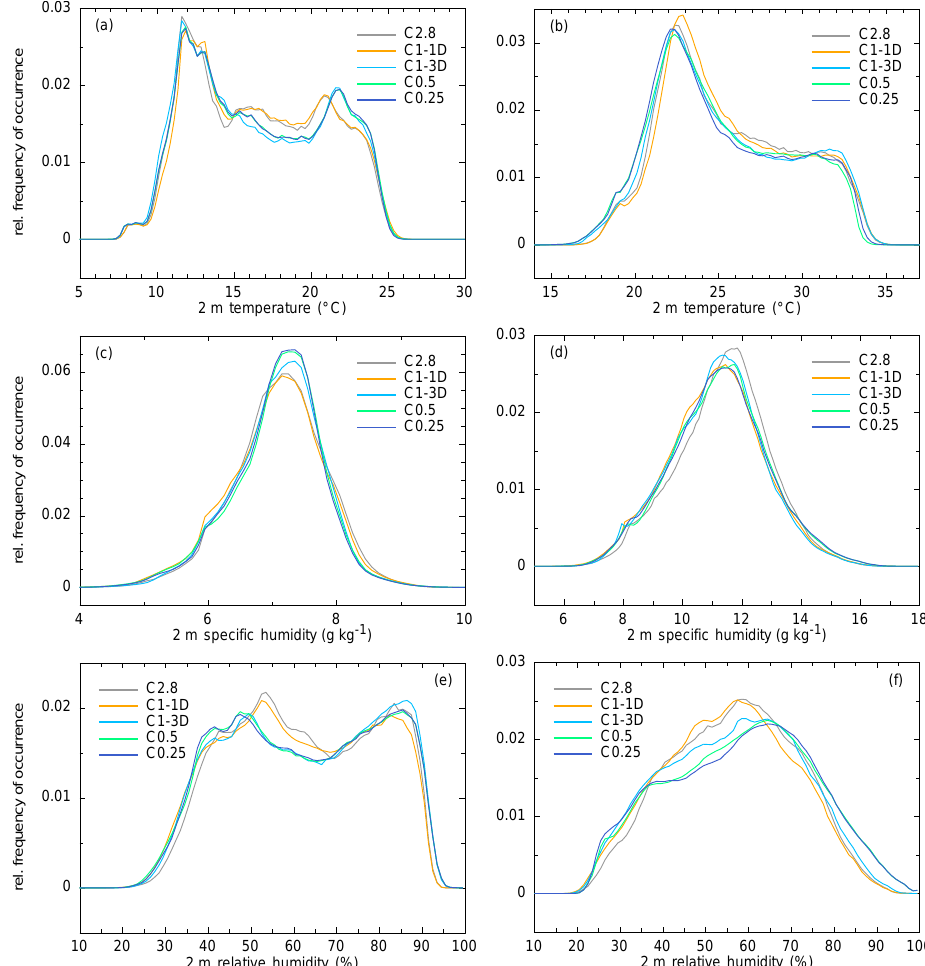
Figure 13. Probability density functions of the 2m temperature (a, b) , 2m specific humidity (c, d) , and 2m relative humidity (e, f) on 25 April (left) and 23 July 2013